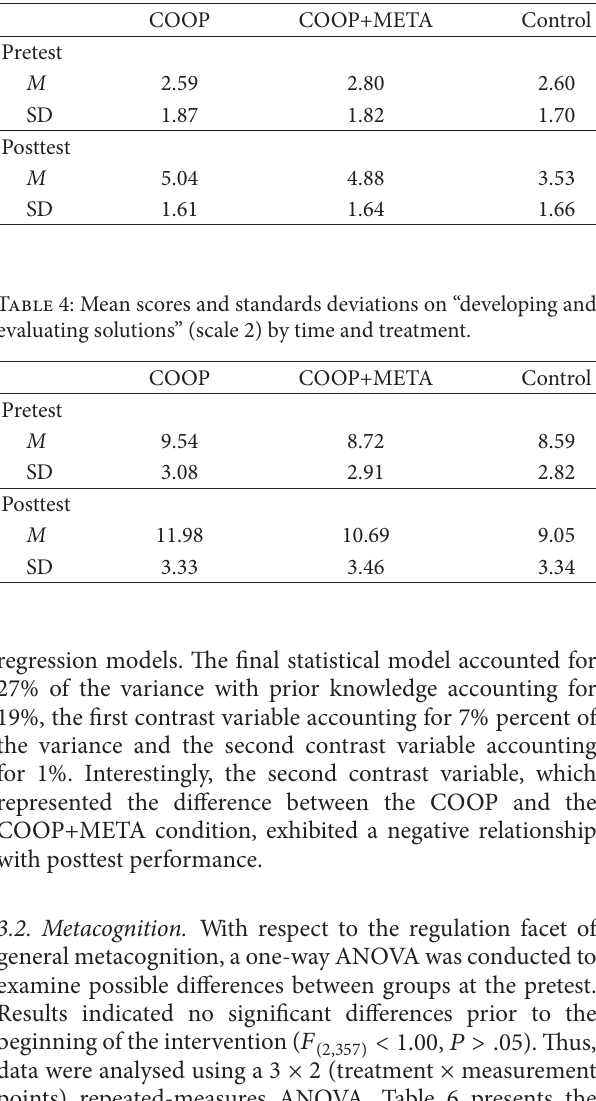
T 3: Mean scores and standard deviations on “describing socio- scienti�c issues” (scale 1) by time and treatment.